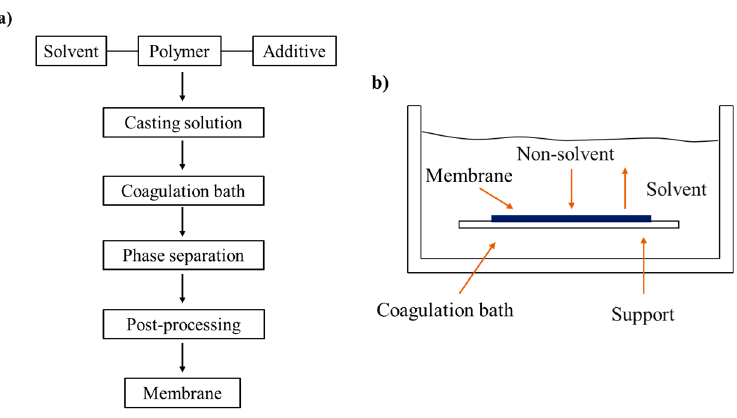
Figure 15. Process of NIPS method (( a ): process of NIPS; ( b ): phase separation process).